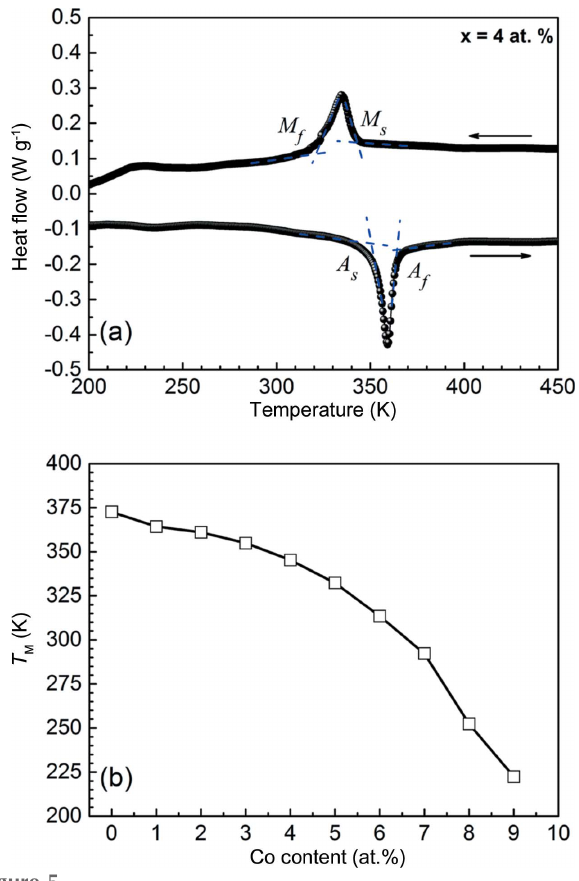
Figure 5 ( a ) DSC curves for Mn 50 Ni 38 Co 4 Sn 8 ribbon samples. ( b ) The composi- tional dependence of T M forMn 50 Ni 42 (cid:2) x Co x Sn 8 ribbons, with x from0 to